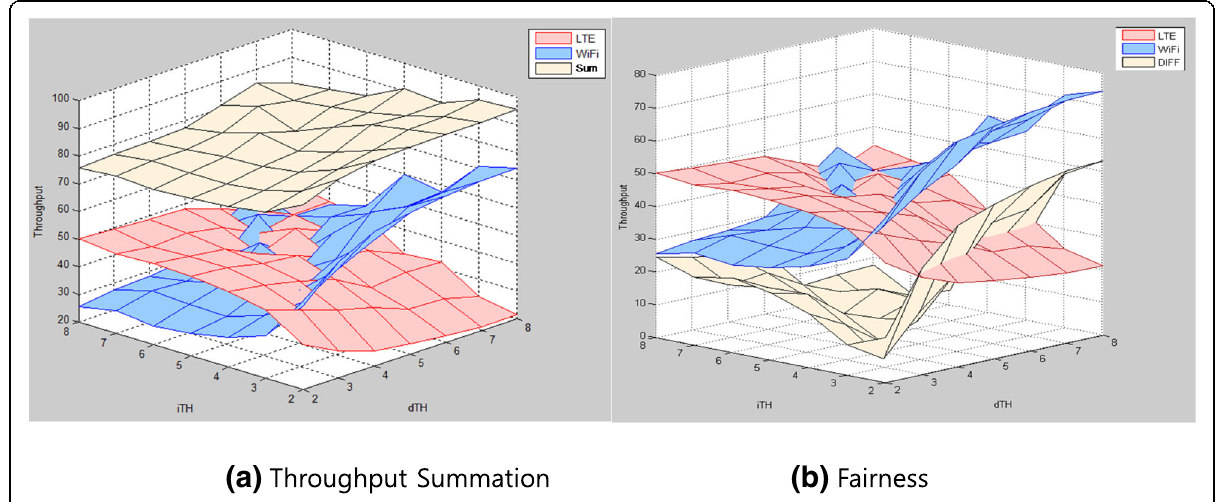
Fig. 5 3D Throughput analysis. a Throughput summation. b Fairness